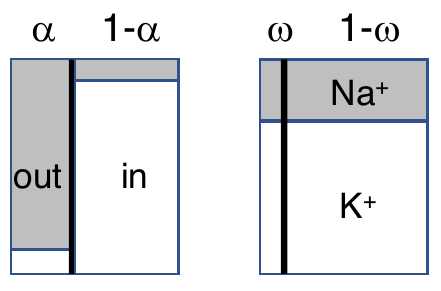
Figure 1. Diagram of the model, showing the extra- and intracellular compartments, separated by the membrane barrier (thick vertical line), before ( left ) and after mixing ( right ). Widths (not to scale) indicate relative compartmental sizes, heights relative concentrations of Na + (gray) and K + (white). Only the monovalent cations of Table 1 are